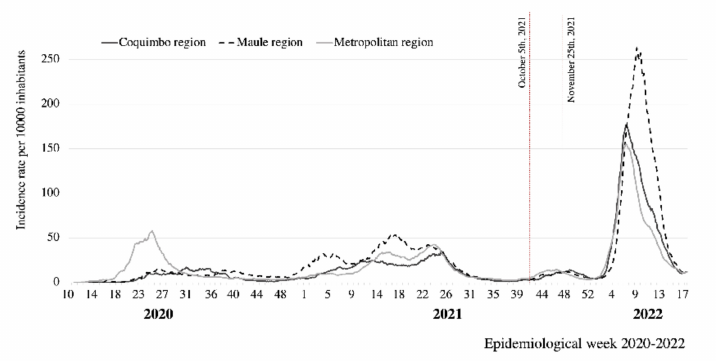
Figure 1. COVID-19 epidemic curve in three regions of Chile, 2020–2022. Source: [10].